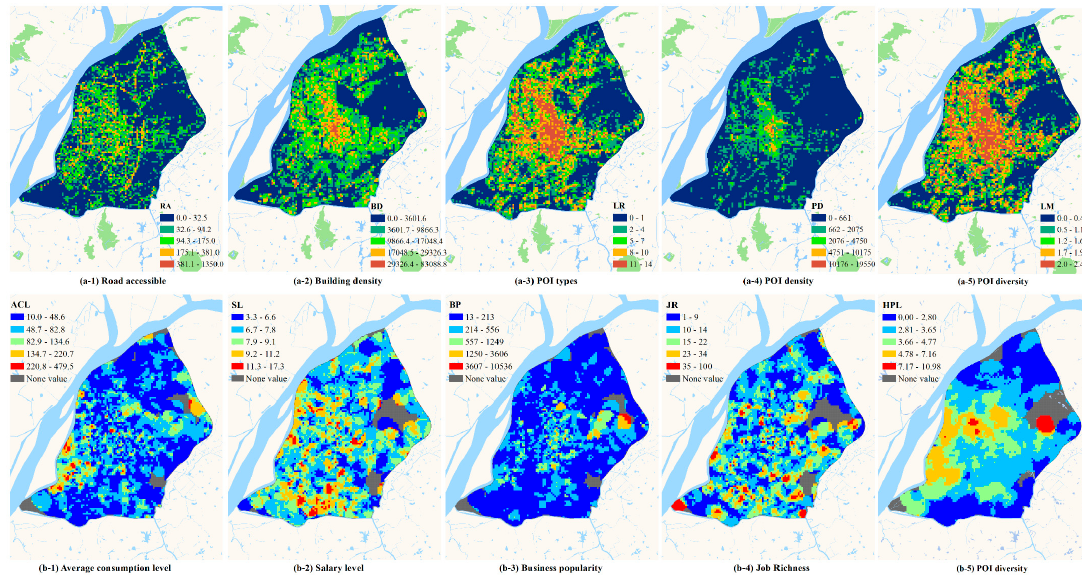
Figure 6. Visualization of urban physical environmental factors and human–land interaction indicators estimate results. ( a -1) to ( a -5) show the spatial distribution of physical environmental factors in the study area; ( b -1) to ( b -5) show the characteristic distributions of social dimension factors. The statistical unit of the physical environment density indicators is km 2 . 3. Urban vitality spatial regression results